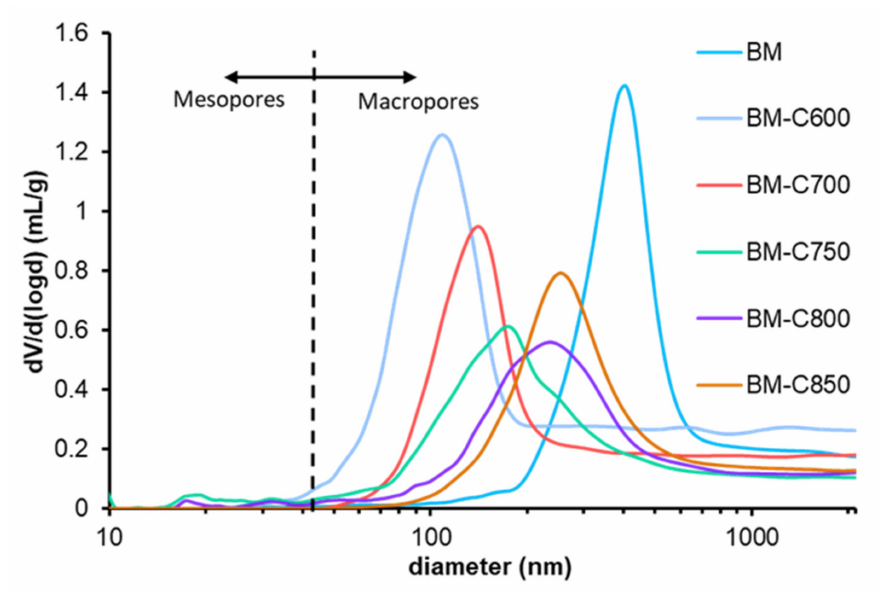
Figure 4. Logarithmic pore size distribution of the BM-CX series and BM.